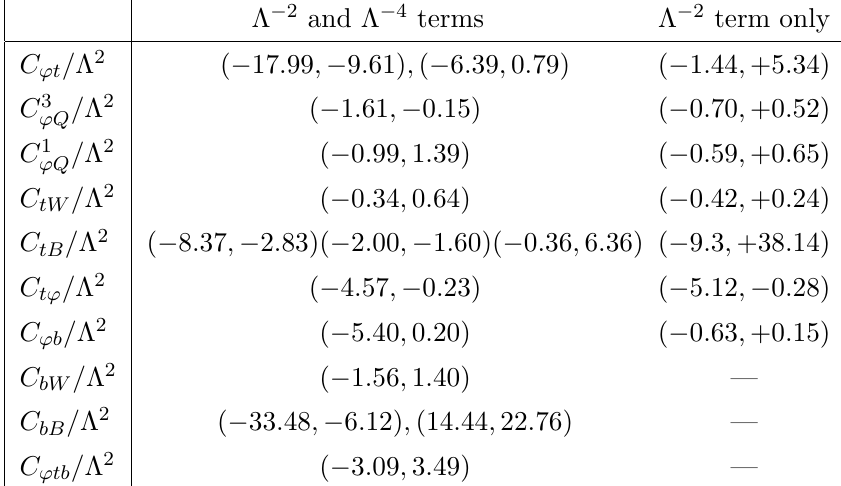
Table 2 . The 68% probability intervals on the dimension-six operator coefficients in units of TeV − 2 . These results are obtained with a fit to LHC and LEP/SLC data for two parameterizations of the dependence of the observables on dimension-six operator coefficients. The first column lists the results from the fit based on the nominal parameterization, which includes terms proportional to Λ − 2 and Λ − 4 terms. The second column is obtained with a fit based on a parameterization that only includes Λ − 2 terms. The coefficient C tϕ is marginalized over in the fit, but discussed separately in section 6.